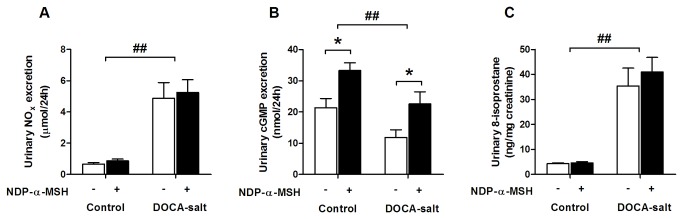
NDP-α-MSH treatment increases urinary excretion of cGMP.Urinary excretion of NO metabolites (A), cGMP (B) and 8-isoprostane (C) in control and DOCA-salt mice. Number of mice analyzed is given in Table 1. * P < 0.05 versus saline group, # # P < 0.01 versus control mice.